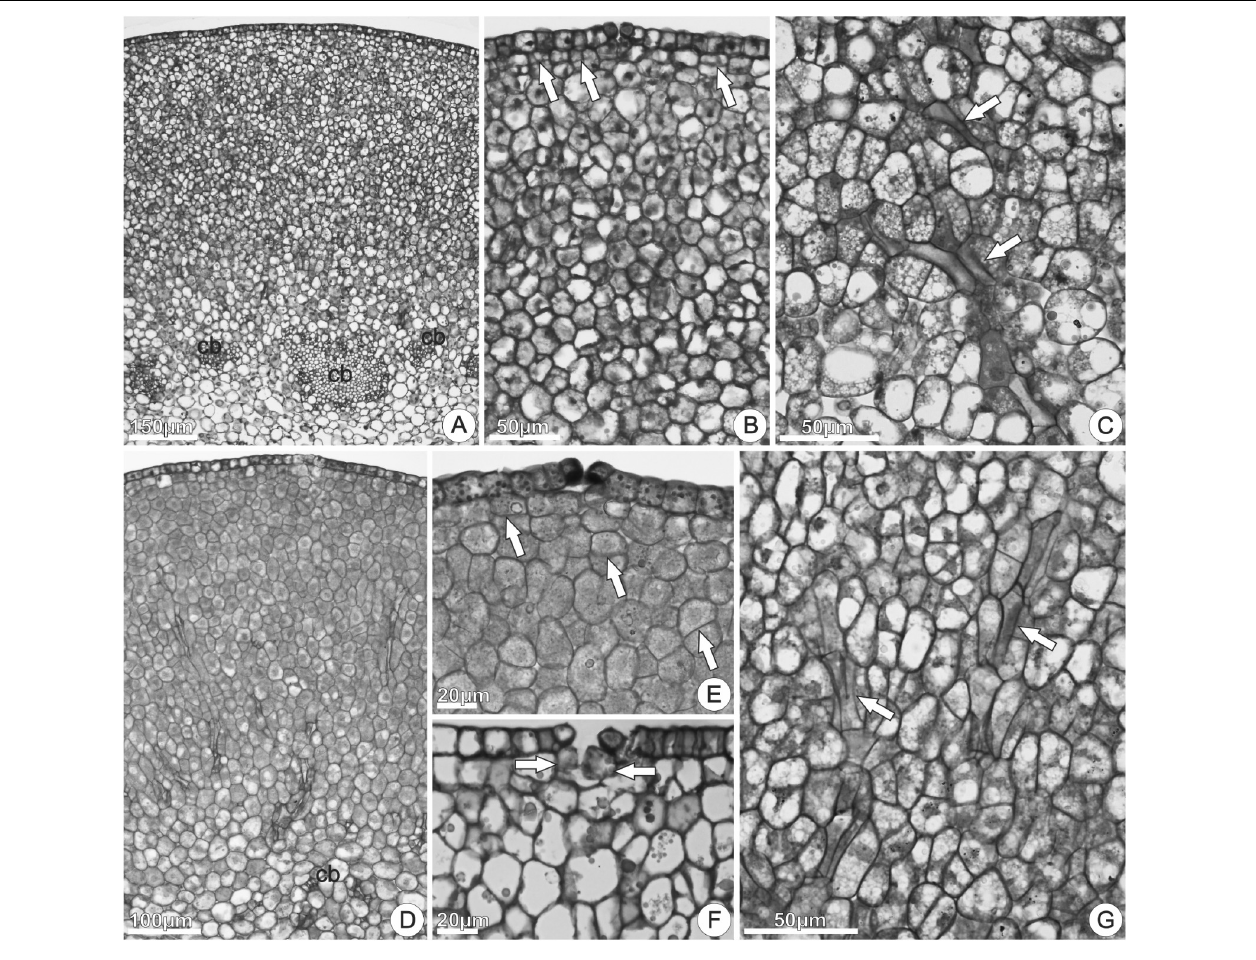
FIGURE 6 | Structure of the floral disk of Jacaranda oxyphylla, illustrated by cross (A,B,D,E,G) and longitudinal (C,F) sections. (A–C) Nectariferous flowers; (D–G) nectarless flowers. (A) General aspect of the disk showing the epidermis, nectary parenchyma, sub-nectary parenchyma and collateral bundles; (B) detail of (A) showing epidermis coated with thin cuticle, stomata, and nectary parenchyma region composed by isodiametric cells. Arrows indicate cell division in the subepidermal layers; (C) subnectary parenchyma with phloem strands (arrows); (D) general aspect of the disk showing the epidermis, parenchyma, and vascular tissues; (E) epidermal cells with dense globules and stomata with associated secretion. Arrows indicate cell division in the subepidermal layers; (F) detached epidermal cells and large parenchyma cells inside substomatic chamber (arrows); (G) phloem strands (arrows) in the parenchyma tissue. cb, collateral